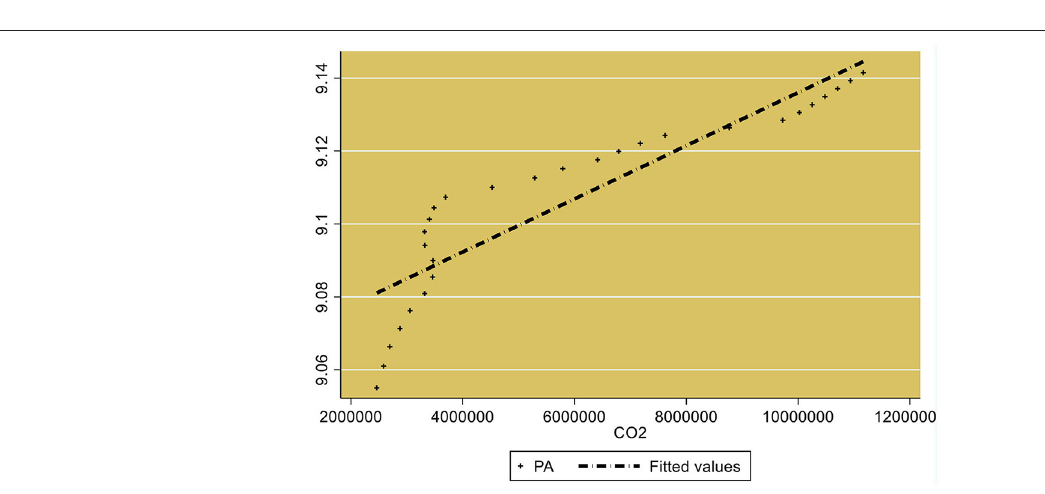
FIGURE 4 | Scatterplots of population vs. CO 2